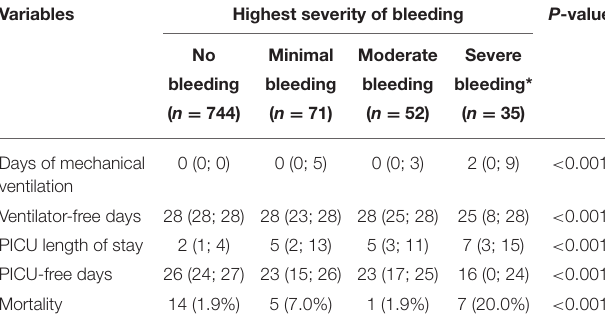
TABLE 4 | Clinical outcomes of the entire cohort ( n = 902).